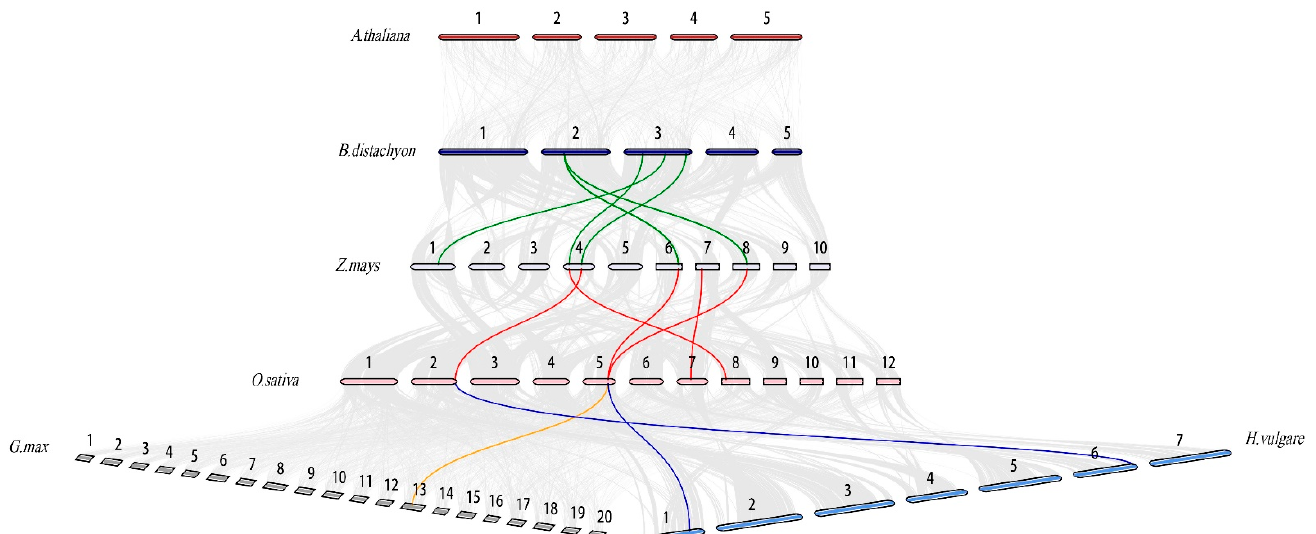
Figure 2. Synteny analysis of Arabidopsis thaliana , Oryza sativa , Brachypodium distachyon , Zea mays , Glycine max , and Hordeum vulgare . The chromosomes of different species are represented by long bars of different colors.